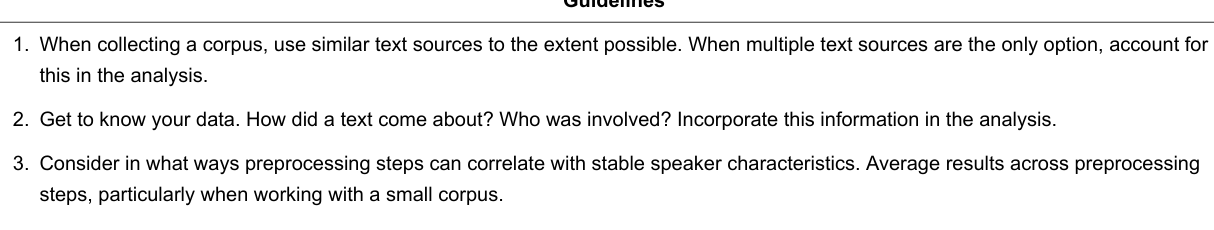
Guidelines for Text as Data Projects in Political Psychology and Political Science